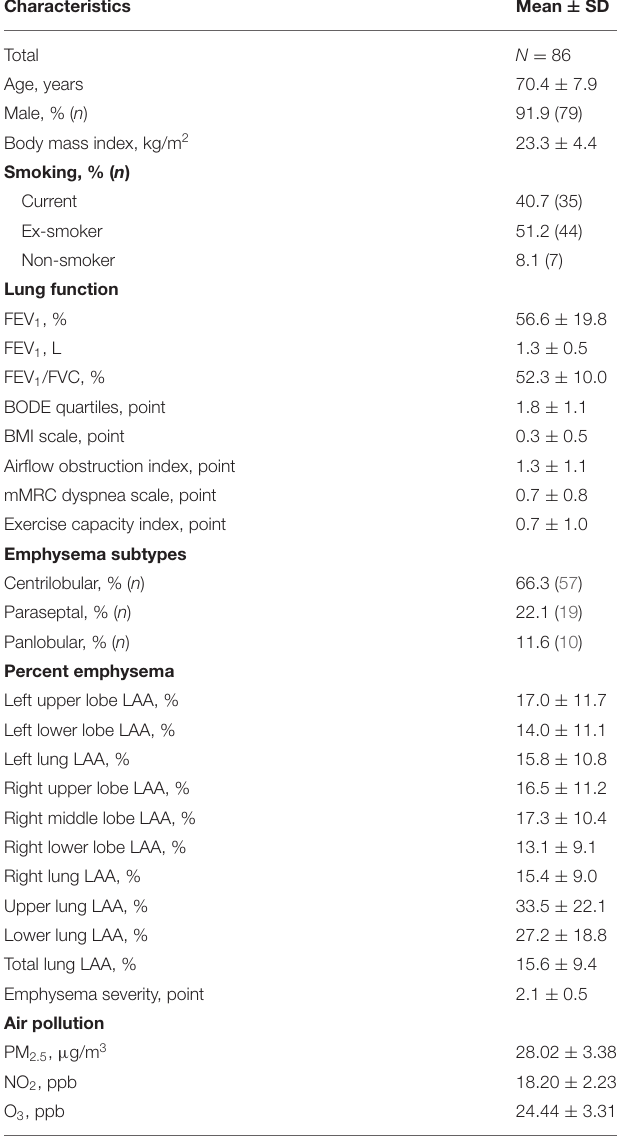
TABLE 1 | Demographic characteristics of study subjects.